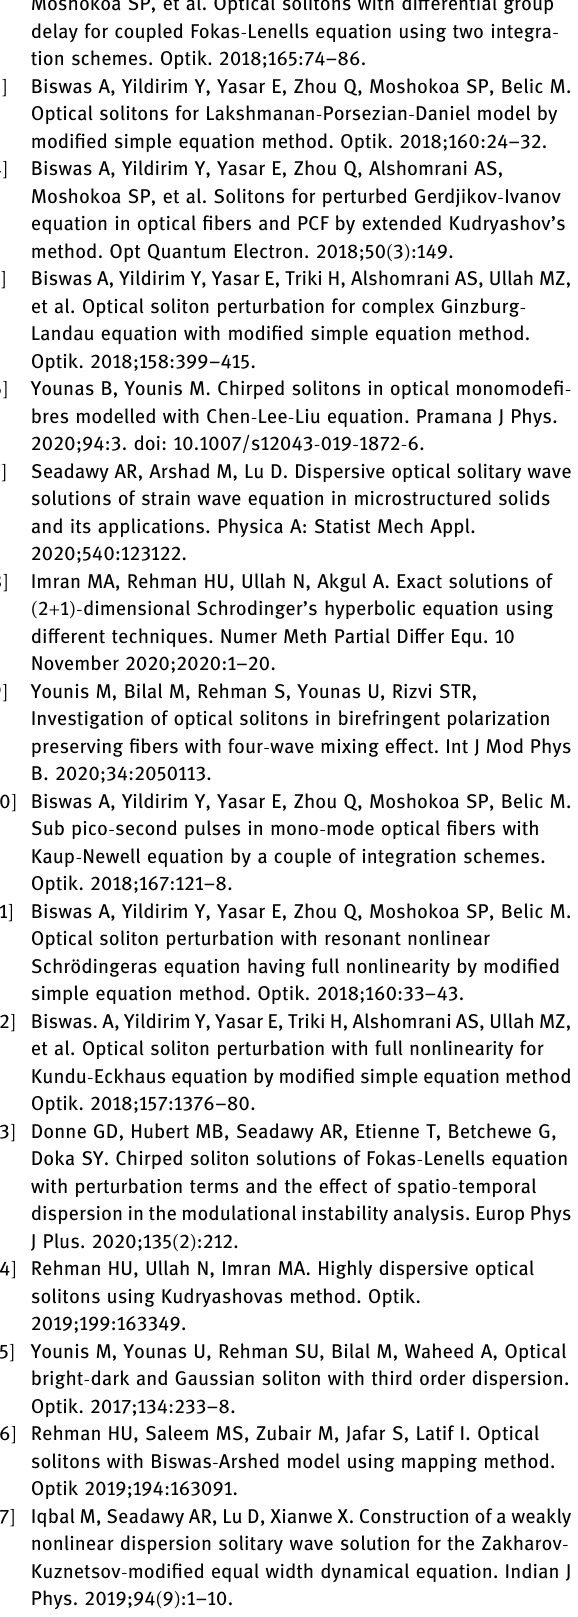
Figure 7, the absolute behavior of ( 83 ) with the suitable values of parameters =